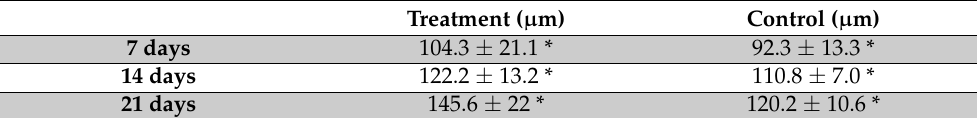
Table 5. Retinal thickness measurements ( μ m) of the OD from treatment ( n = 12) and control groups at 7, 14, and 21 days ( n = 12) measured in a distance between 500 μ m and 1500 μ m from the optic nerve.